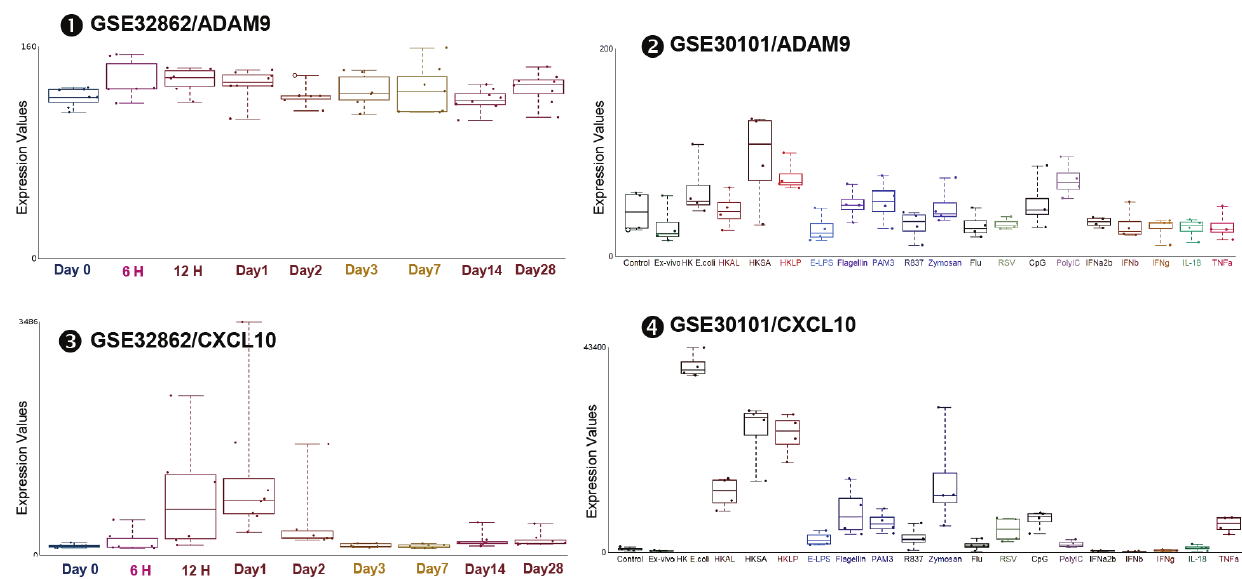
Supplementary Figure 3. These plots are exported directly from the GXB tool and show data supporting the notion that the abundance of ADAM9 increases only marginally following treatment with pathogen-associated molecules as presented in Figure 3 of the manuscript. The interactive version of this plot can be accessed via the links provided